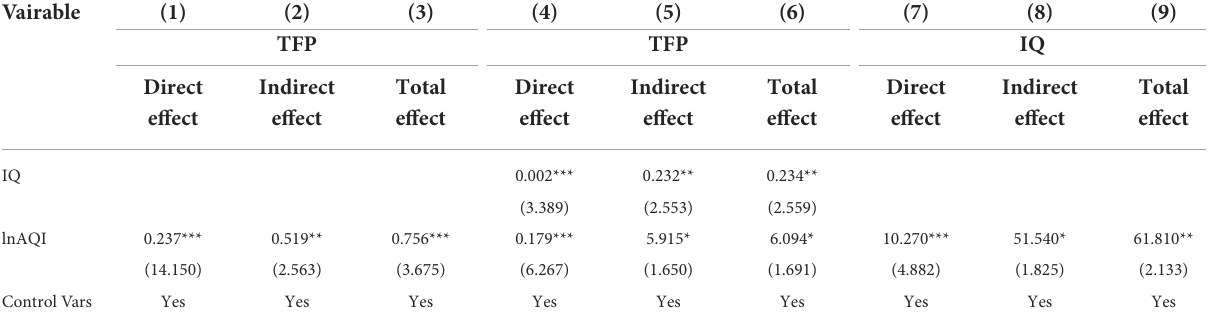
TABLE 14 Decomposition effect of enterprise innovation quality.